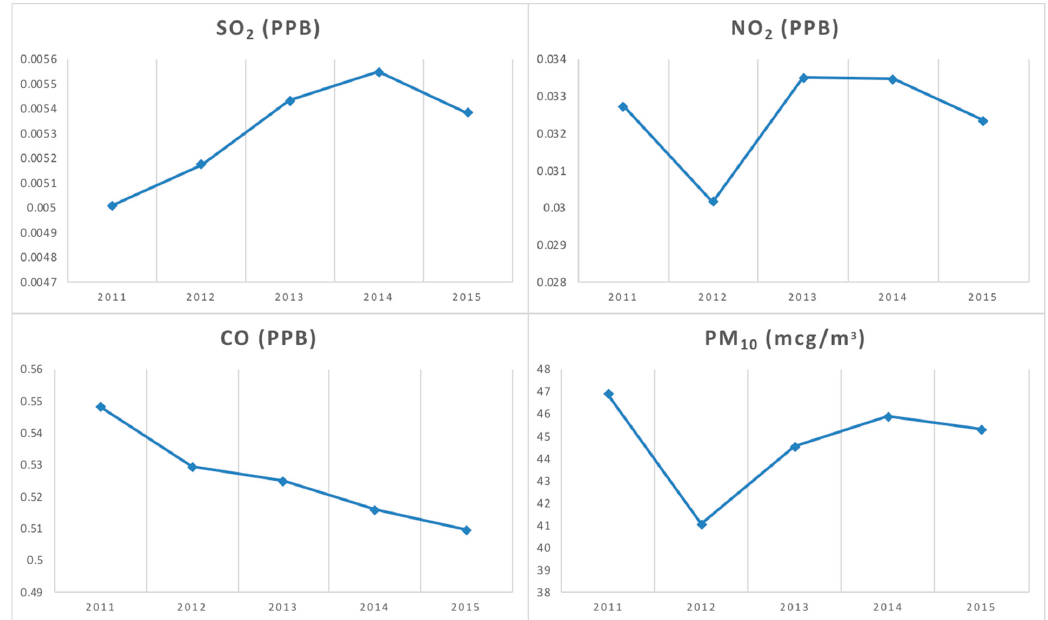
Figure 3. Changes in ambient air pollutants in Seoul between 2011 and 2015. Table 1. Univariate autocorrelation measures of allergic disease prevalence and air pollutants (global Moran’s coefficient).